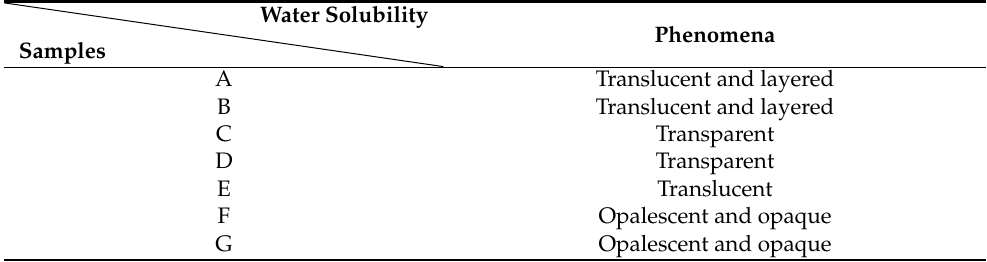
Table 2. Effect of the ratio of anhydride and hydroxyl groups in EB on the water solubility of coatings.